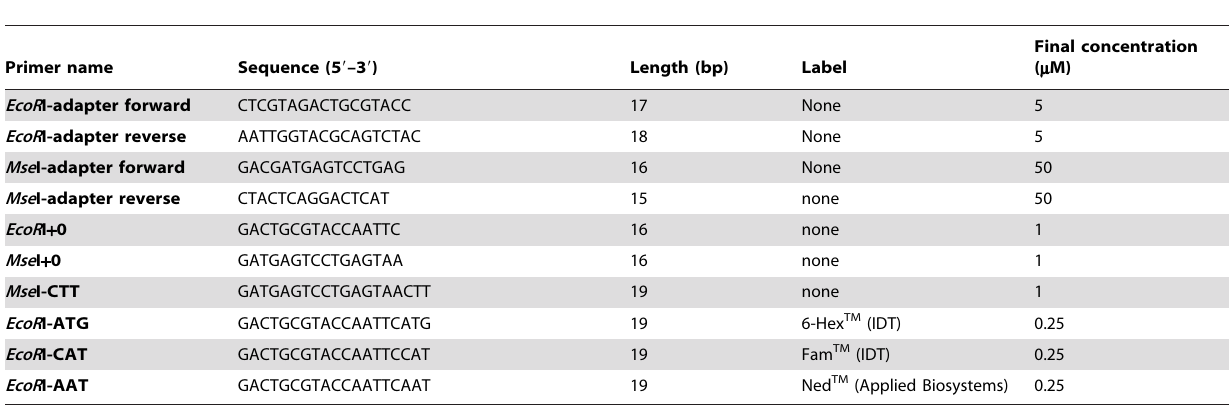
Table 1. Oligonucleotide sequences for all the primers required for the standardized AFLP